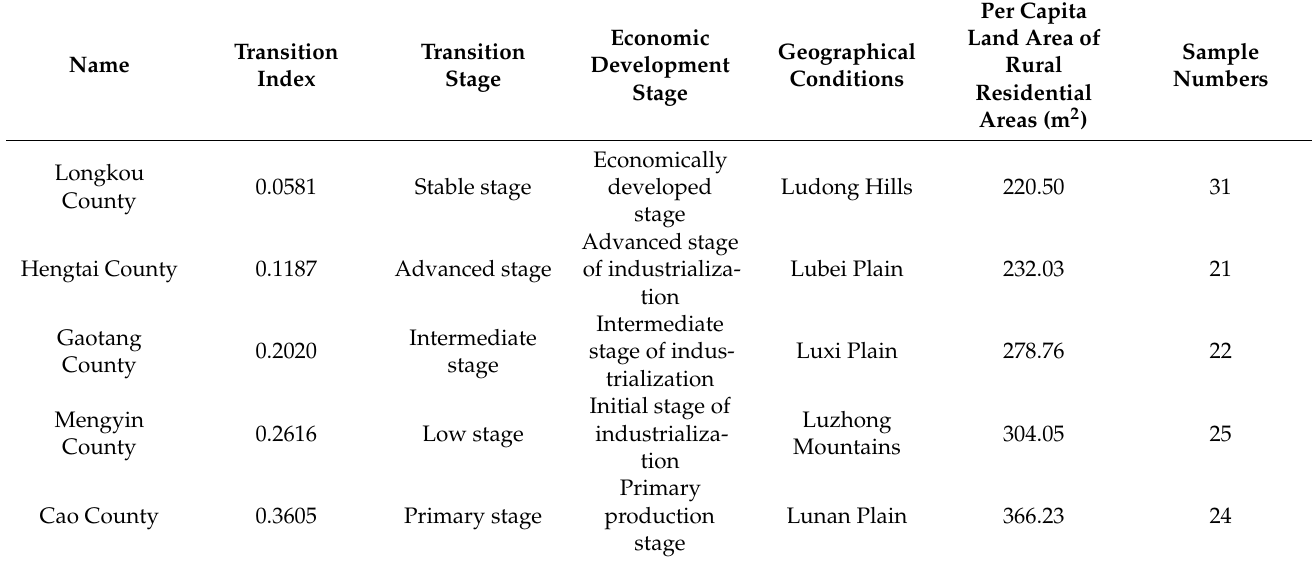
Table 7. Basic profile of rural residential land in typical areas.